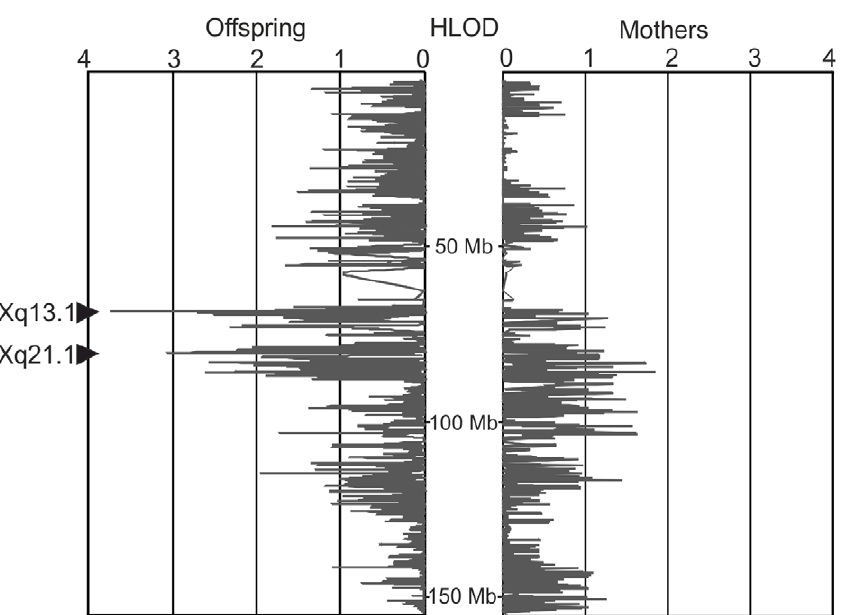
Figure 2. HLOD scores in parametric linkage analysis of X chromosomal markers in spontaneous preterm birth. HLODs for the affected offspring phenotype are shown on the left and those for the affected mother phenotype on the right. The position of the marker yielding a significant linkage signal (SNP rs6525299 on Xq13.1, HLOD of 3.72) for the affected offspring phenotype is shown. The position of the markers yielding the second highest HLODs (SNPs rs11266953 and rs7056400 on Xq21.1, HLODs of 3.05) is also indicated. These three SNPs are intergenic.